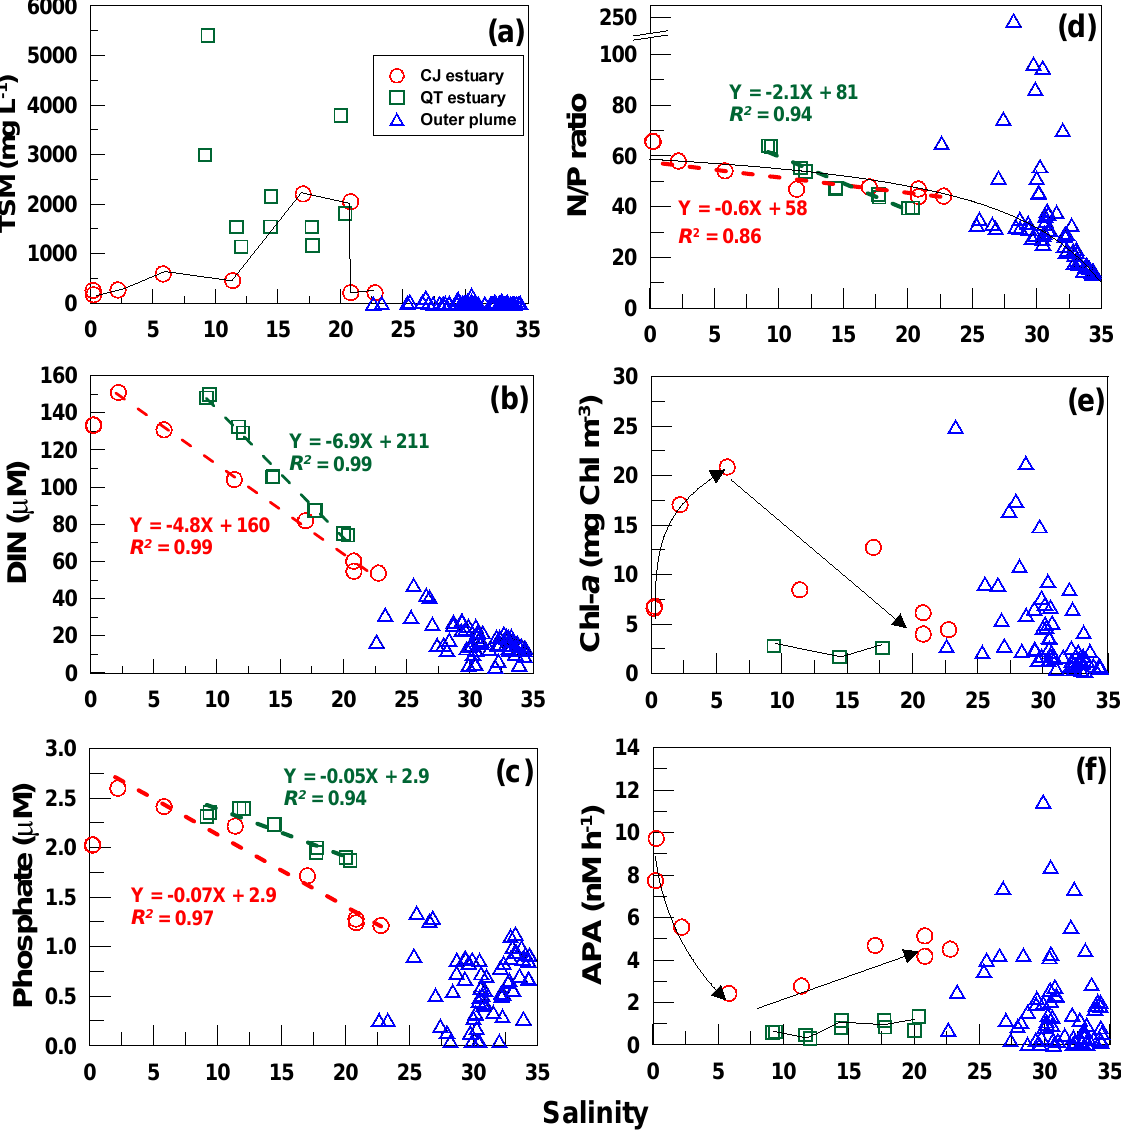
Fig. 4. The variations of TSM (a) , DIN (b) , phosphate (c) , N/P ratio, (d) Chl a (e) , and APA (f) in whole water column along estuarine salinity gradient over CJ